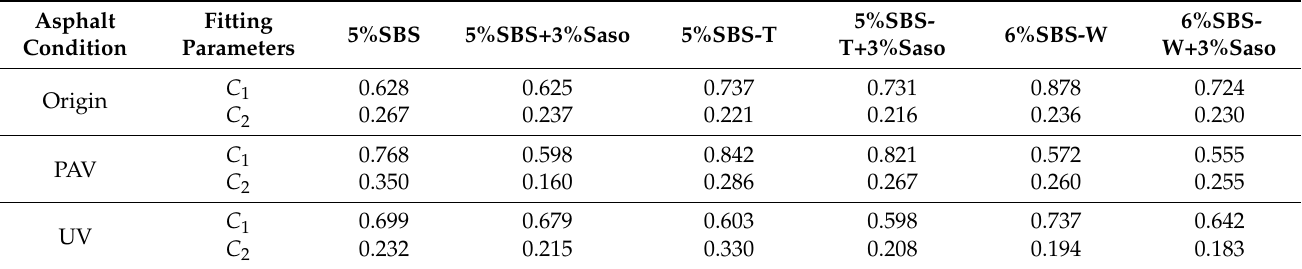
Table 8. DCC curve fitting parameters.